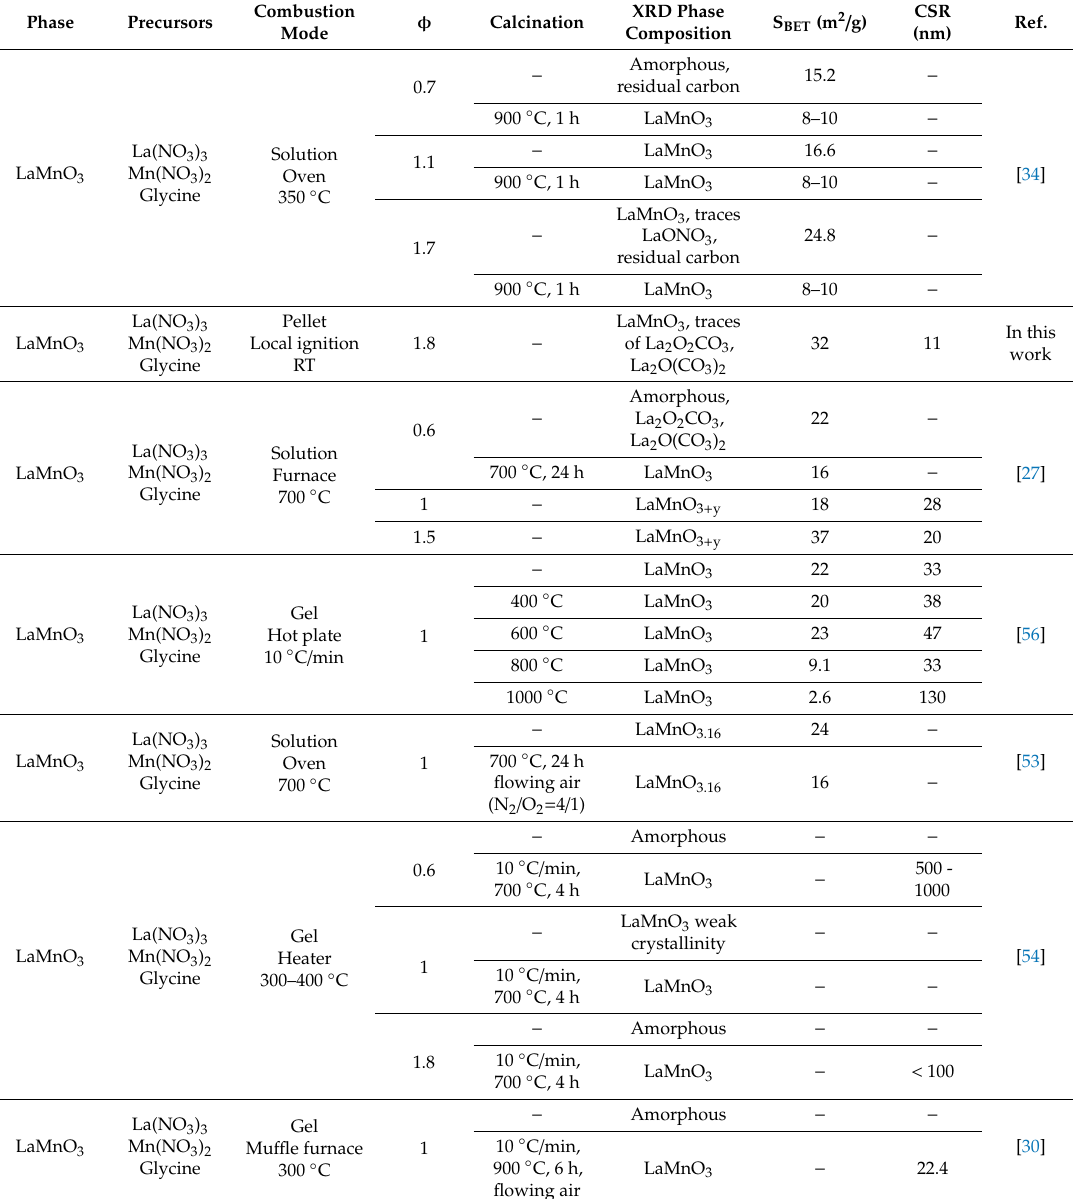
Table 3. Synthesis of LaMnO 3 and LaCrO 3 perovskites using the glycine–nitrate combustion